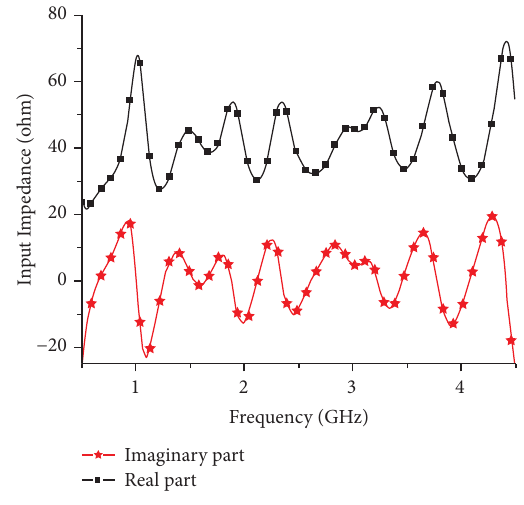
Figure 6: Impedance plot of the antenna.